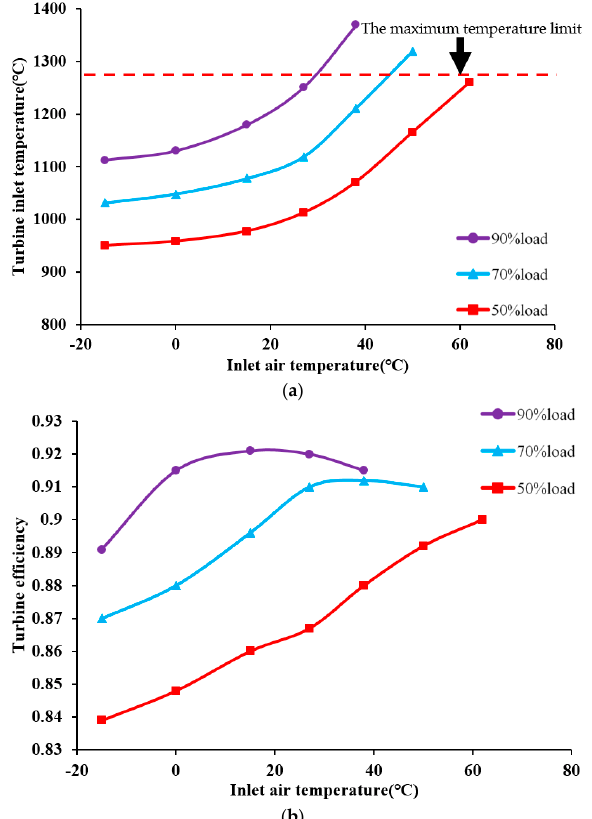
Figure 7. Turbine performance parameters with varying inlet air temperatures. ( a ) Turbine inlet temperature; ( b ) Turbine e ffi